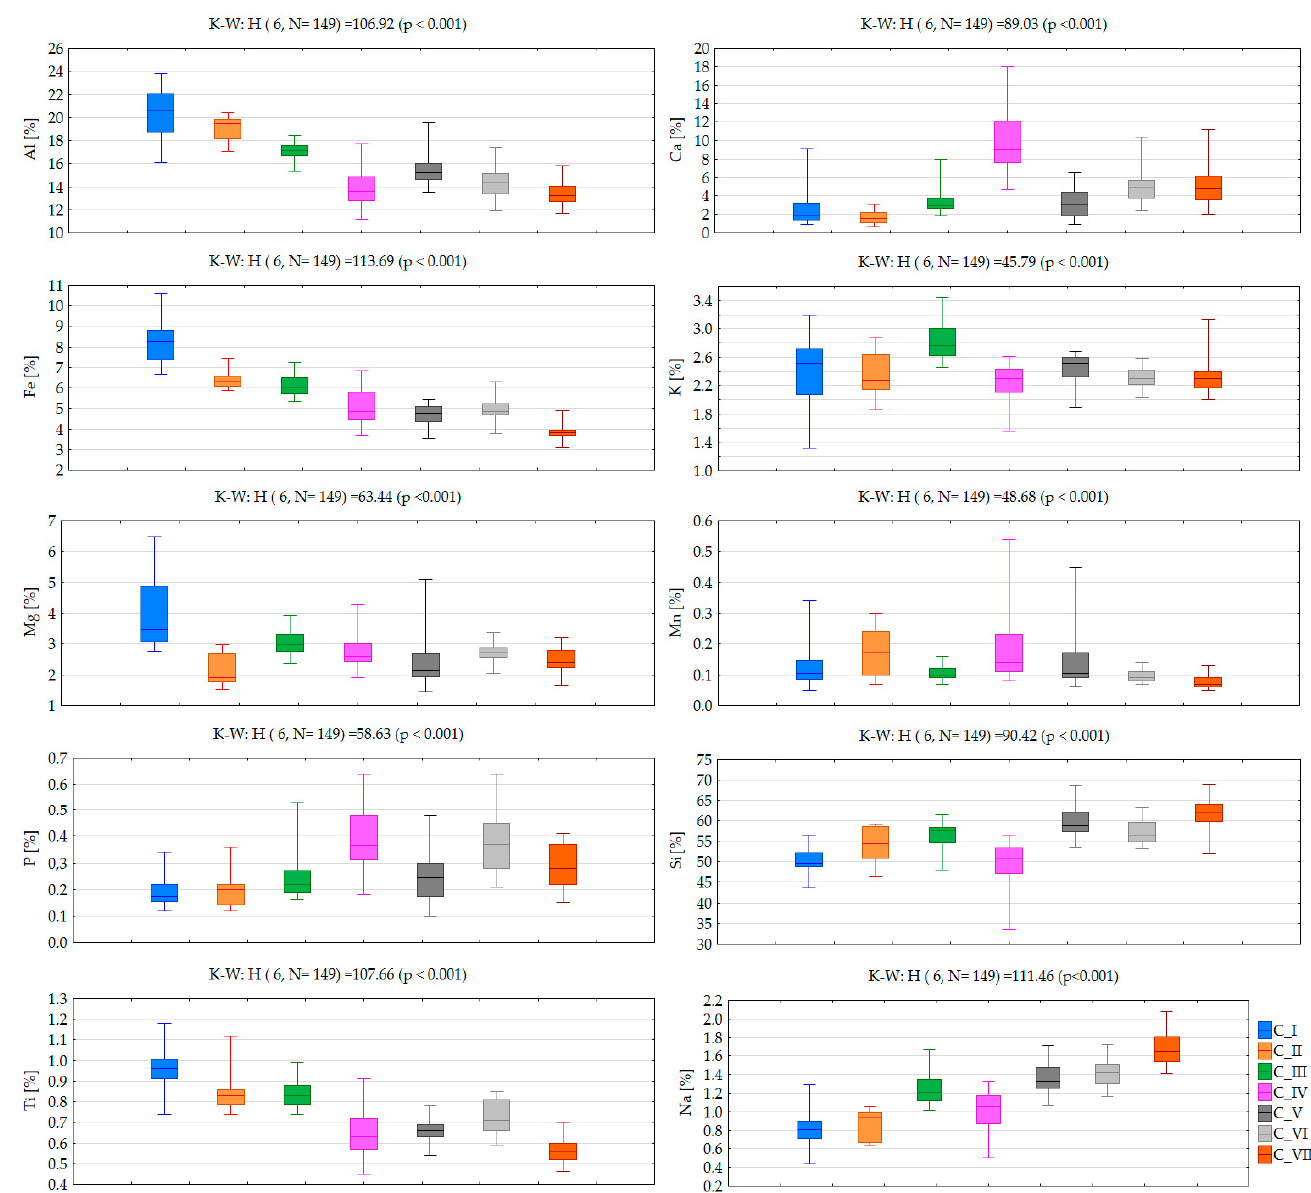
Figure 5. Geological setting of the study area and localization of sampling according to cluster clas- sification. The seven identified clusters—(I) Cr, Co, Fe, V, Ti, Al; (II) Ni, Na; (III) Y, Zr, Rb; (IV) Si, Mg, Ba; (V) Nb, Ce, La; (VI) Sr, P, Ca; (VII) As, Zn, Pb—representing the seven groups in which the elements are associated according to local lithologies, are indicated.